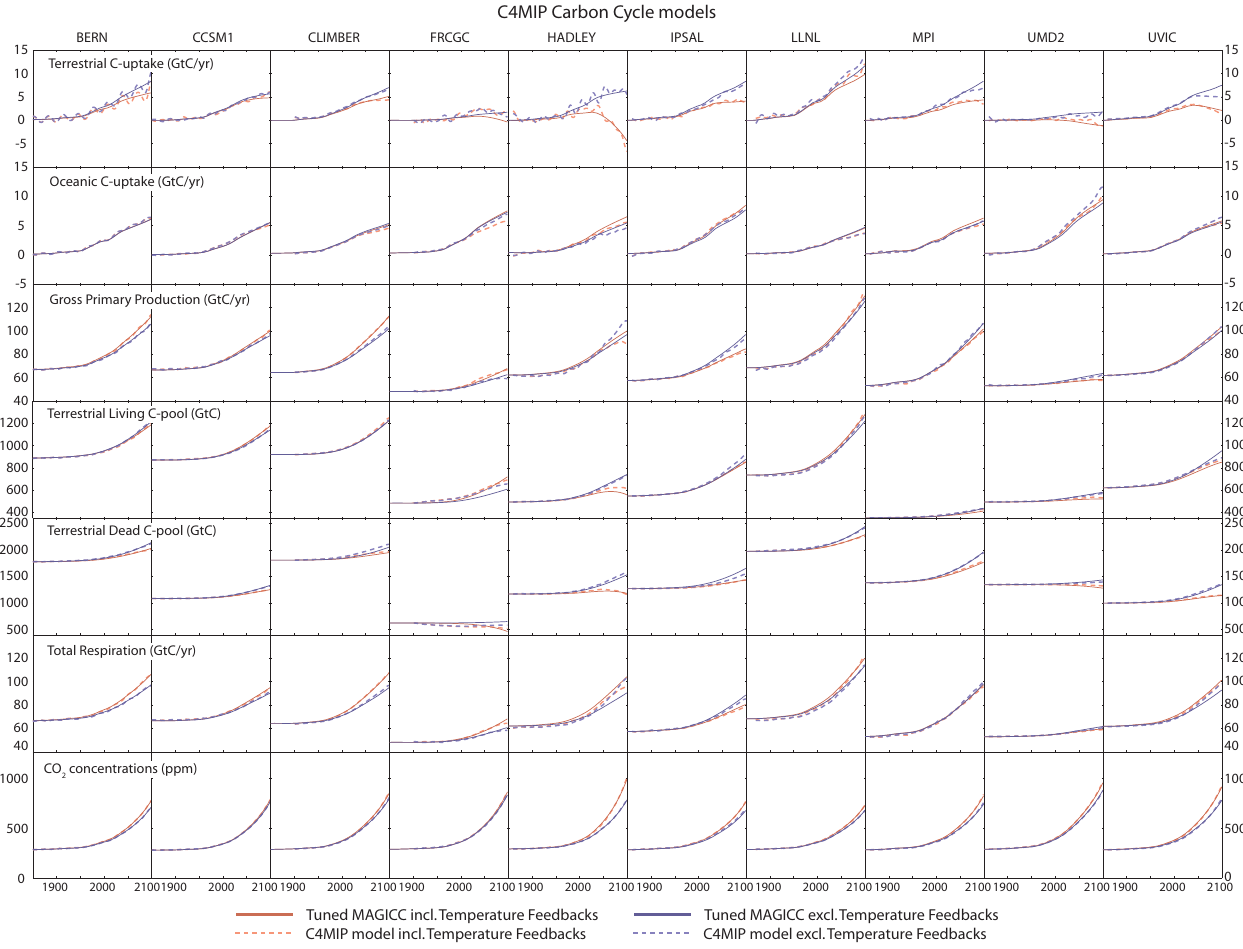
Fig. B4. Comparison of carbon cycle fluxes, pools and atmospheric CO 2 concentrations between C 4 MIP carbon cycle models (dashed) and the calibrated MAGICC6 (solid) model. Shown are the coupled (including temperature feedbacks, red lines) and uncoupled (excluding temperature feedbacks, blue lines) runs for the anthropogenic CO 2 emissions based on the IPCC SRES A2 scenario. The carbon fluxes of the C 4 MIP models were